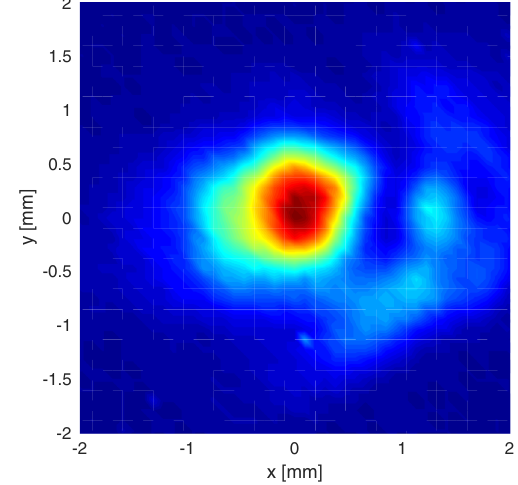
FIG. 14. Examples of numerically generated initial charge distributions for the simulation of the measurement done with the laser distribution depicted in Fig. 13, “ old Gaussian ” represents a regular 3 σ Gaussian distribution, while the “ new Gaussian ” was generated with a 15 σ environment. Thus the latter one also covers low density regions of the transverse laser intensity disproportionately, however, yields results closer to the one of the actual measurement as it sort of compensates for outlying parts of the laser distribution, compare Fig. 16. The graphical representation given here was generated with far less pseudoparticles than the actual